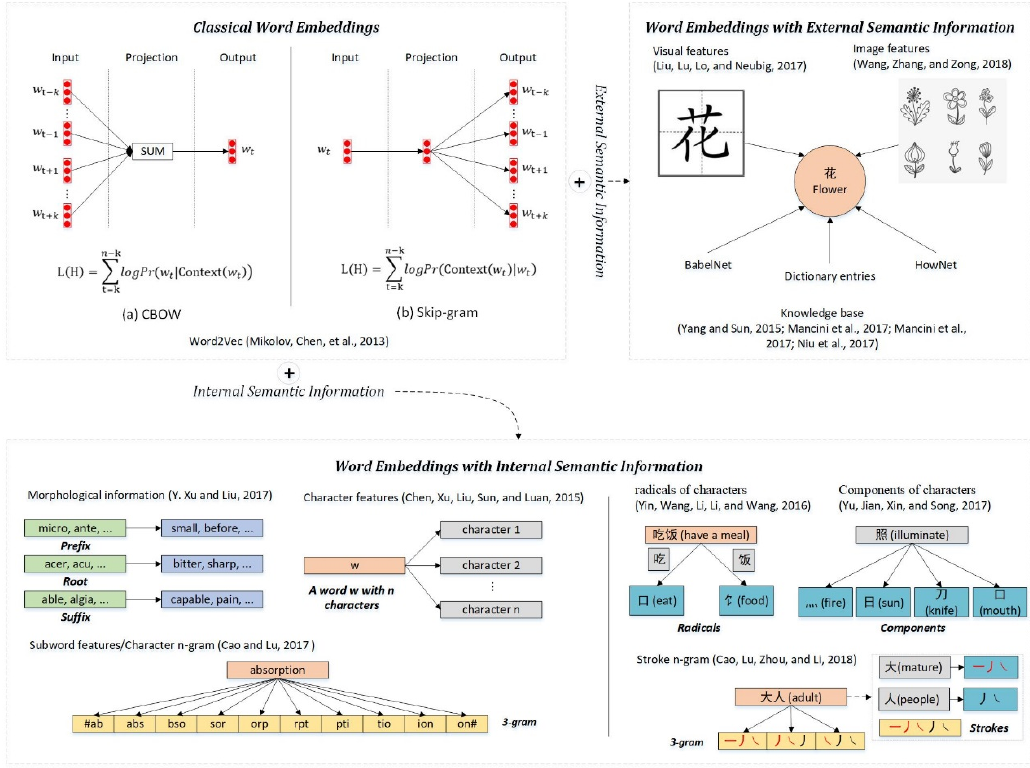
Figure 4. Several typical works of word embeddings.